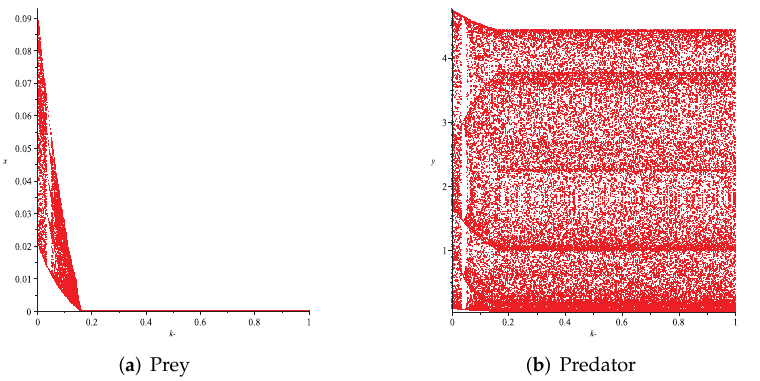
Figure 18. Variation of prey and predator densities with parameter k ( m = 0.6, r 0 = 1.5, h = 3).